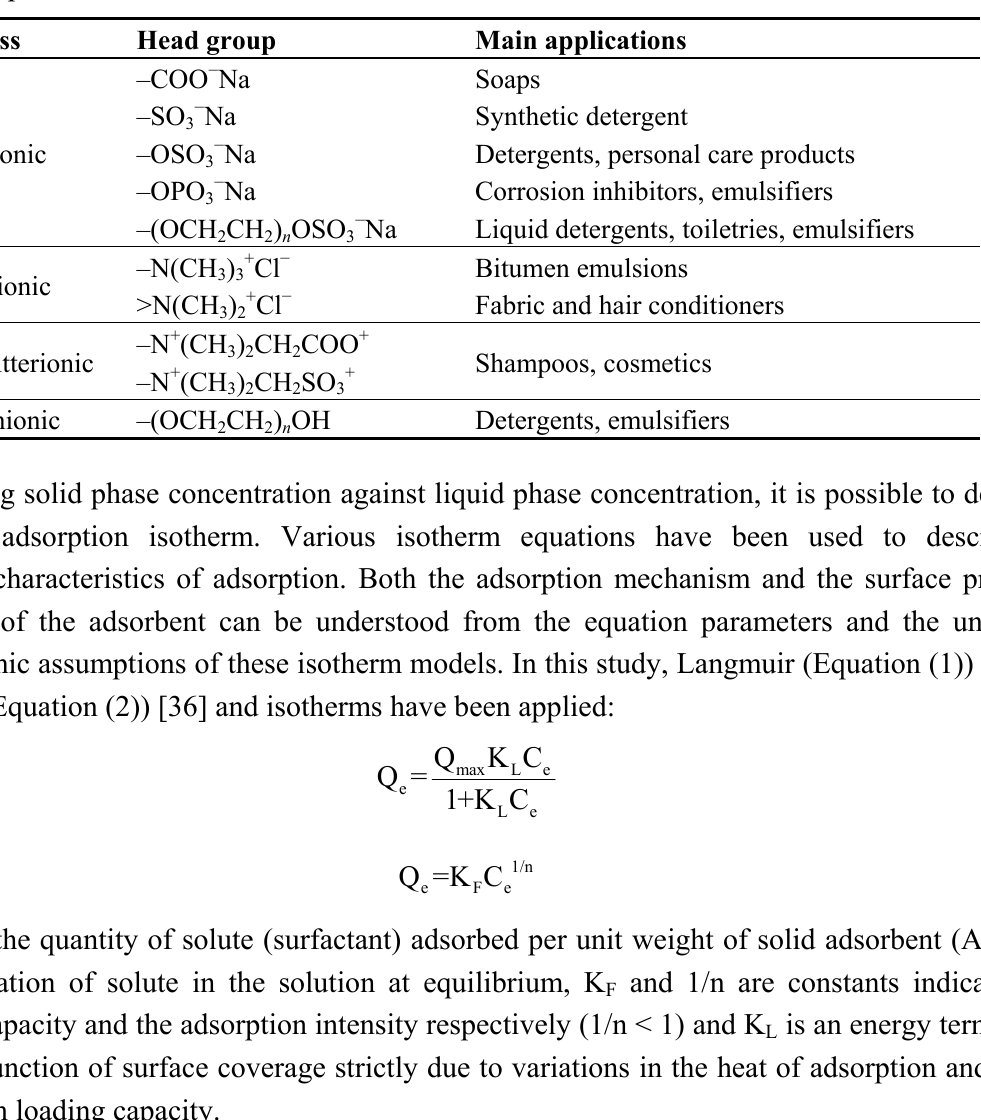
Table 1. Different types of hydrophilic groups of surfactant molecules and their main